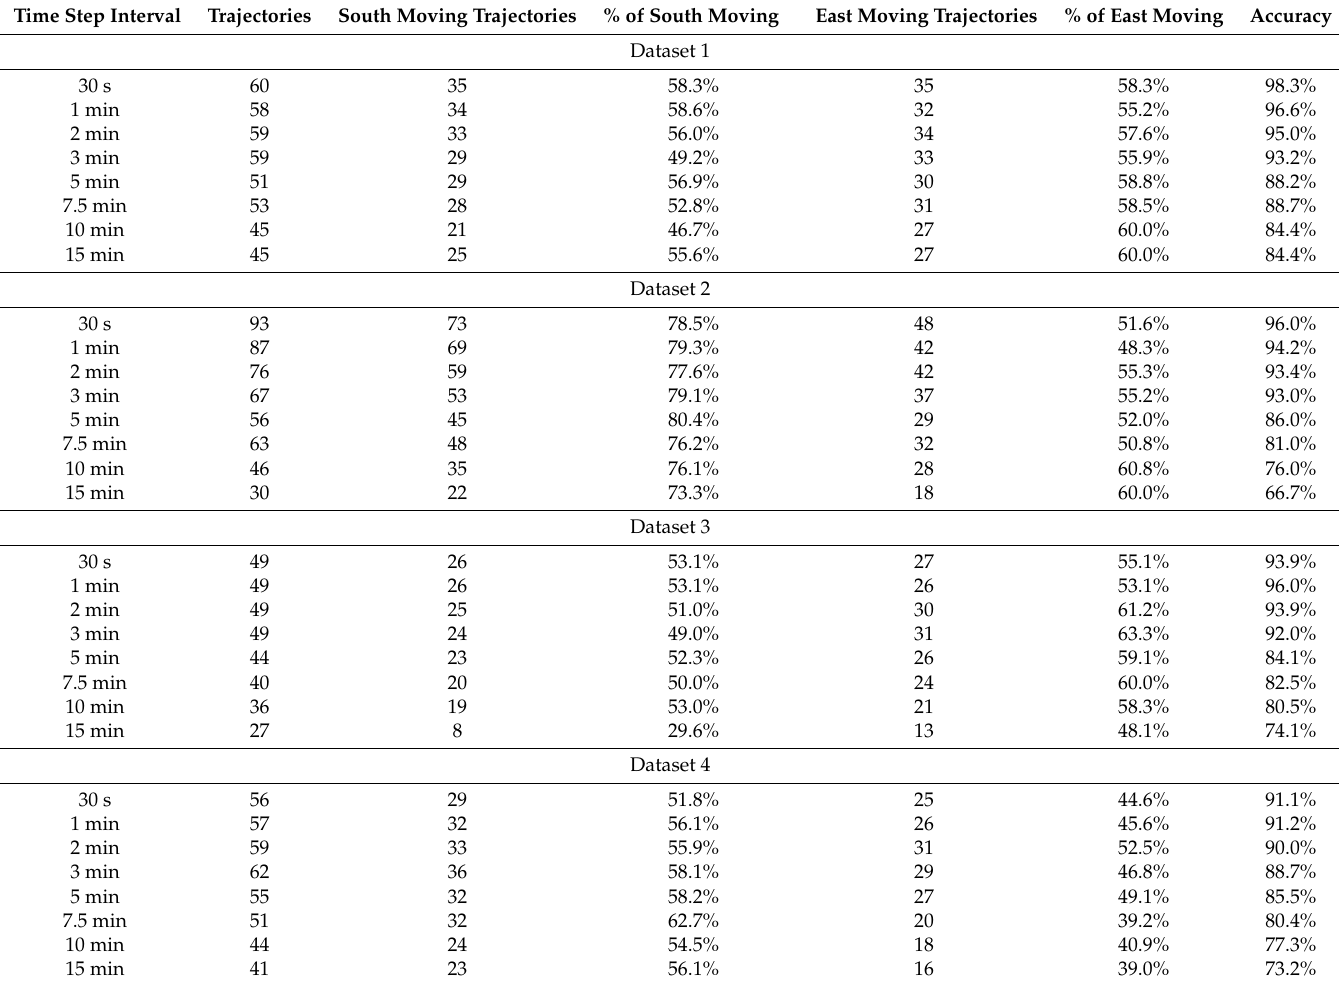
Table 1. Summary of our tracking results from all four datasets using the first algorithm. Accuracy is obtained through comparison between the automatically tracked trajectories to those that have been manually tracked by a human